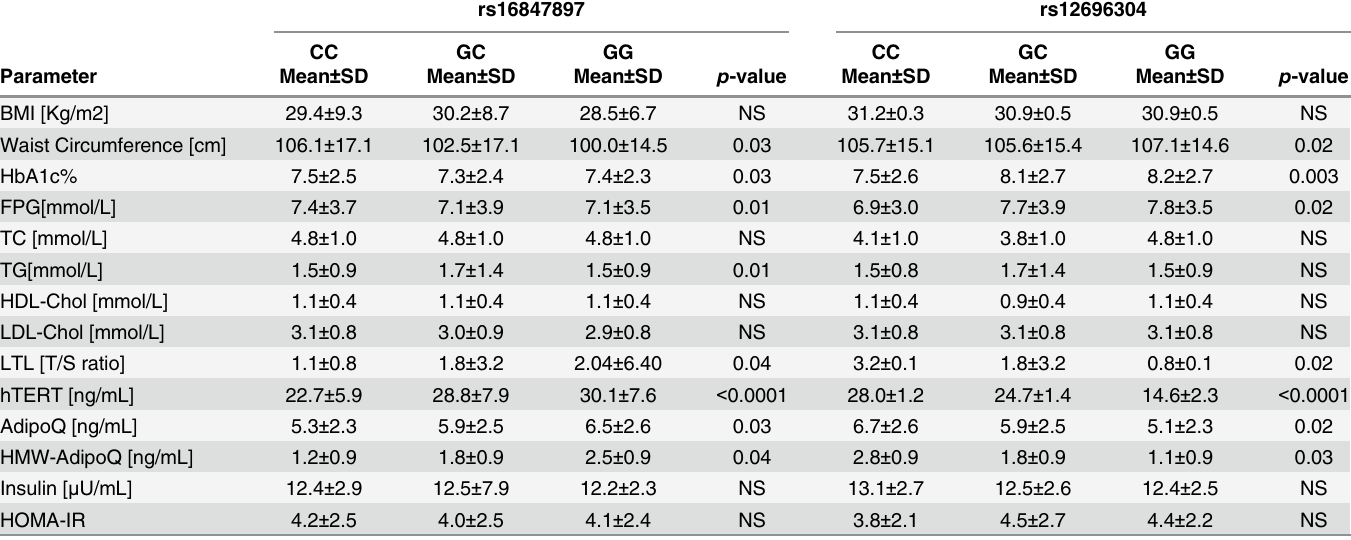
Table 2. Anthropometric and biochemical characteristics according to TERC SNPs rs16847897 and rs12696304 genotypes in the study